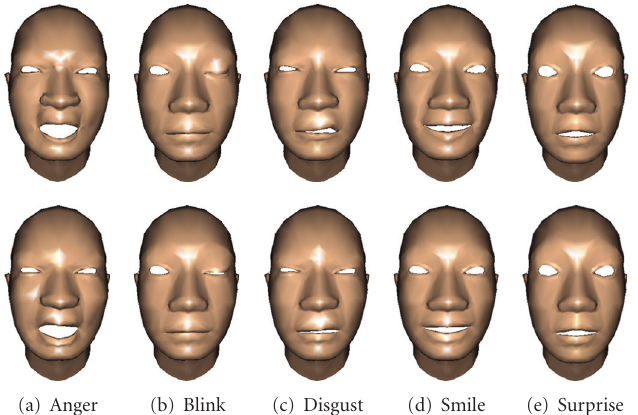
Figure 3: First row shows the original face model and the second row shows the face models generated using facial parameters calculated from the original models.